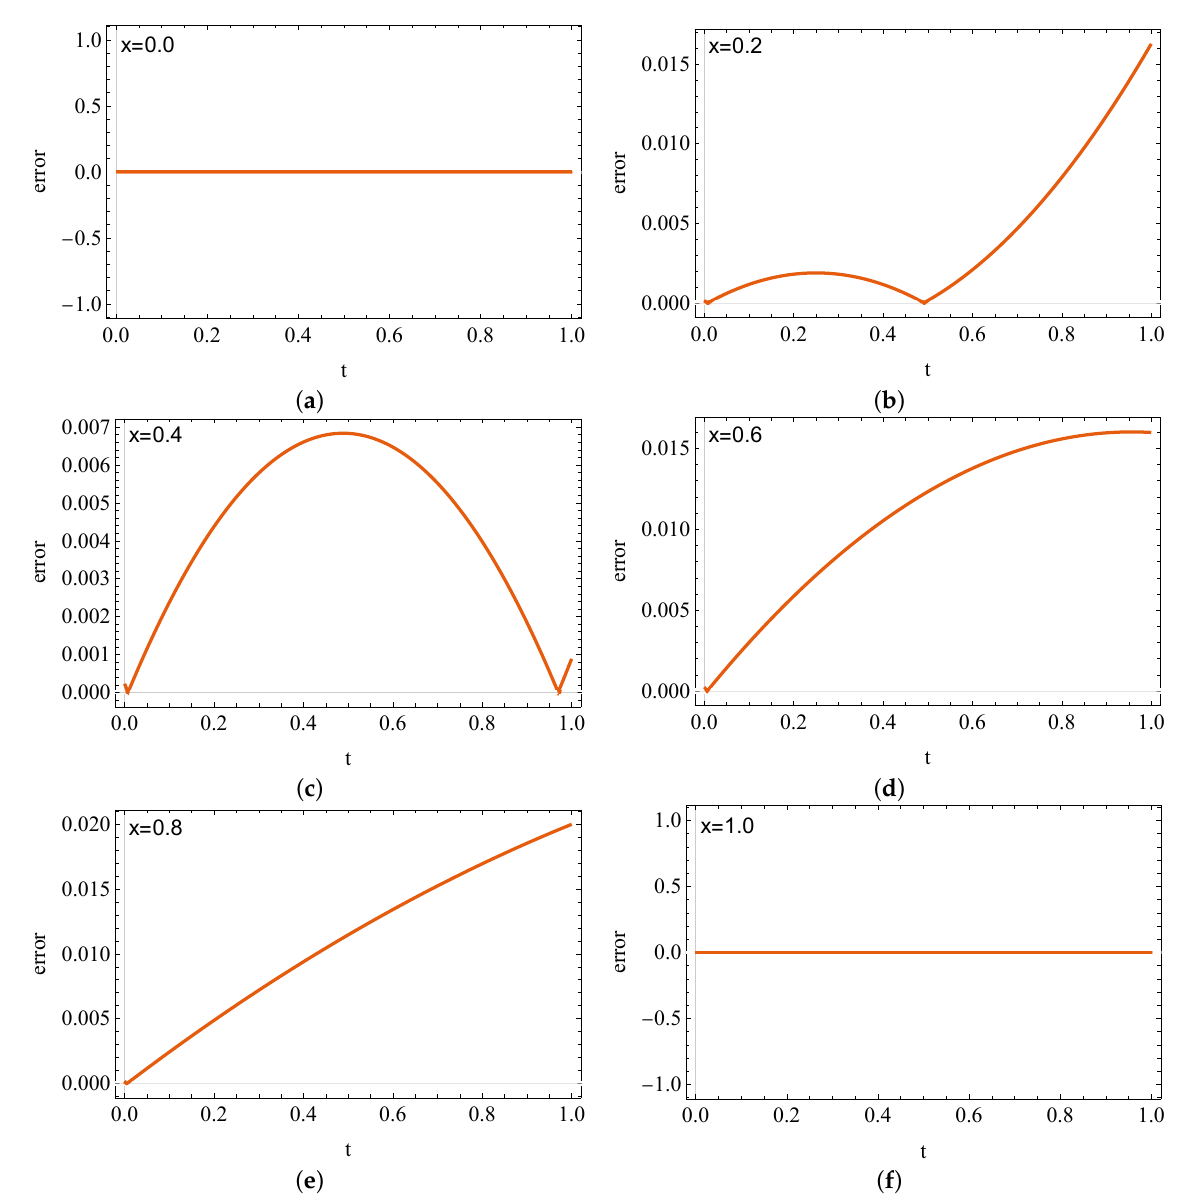
Figure 5. Errors | u e ( x , t ) − (cid:98) u 10 ( x , t ) | for different values of variable x : ( a ) x = 0, ( b ) x = 0.2, ( c ) x = 0.4, ( d ) x = 0.6, ( e ) x = 0.8, ( f ) x =